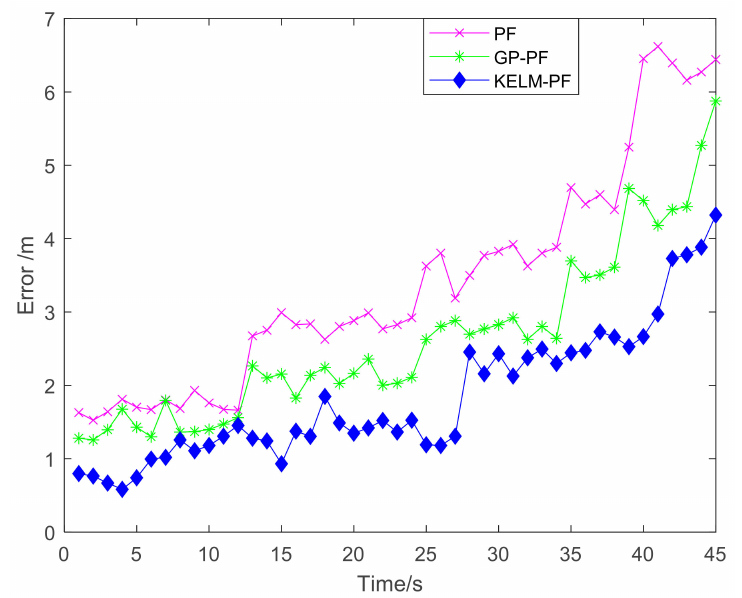
Figure 7. The position results of PF, GP-PF and KELM-PF.